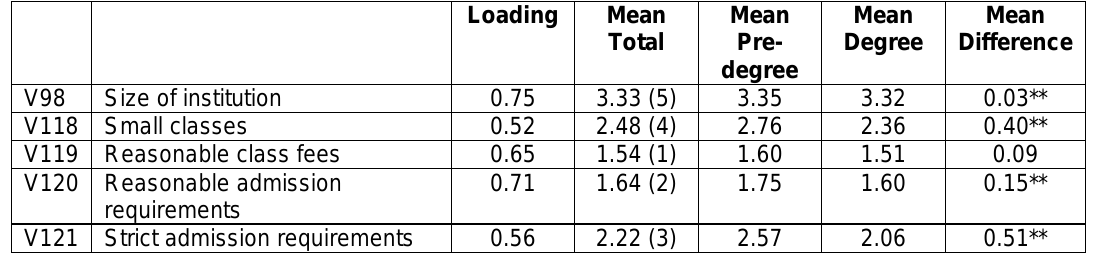
Table 4: Admission